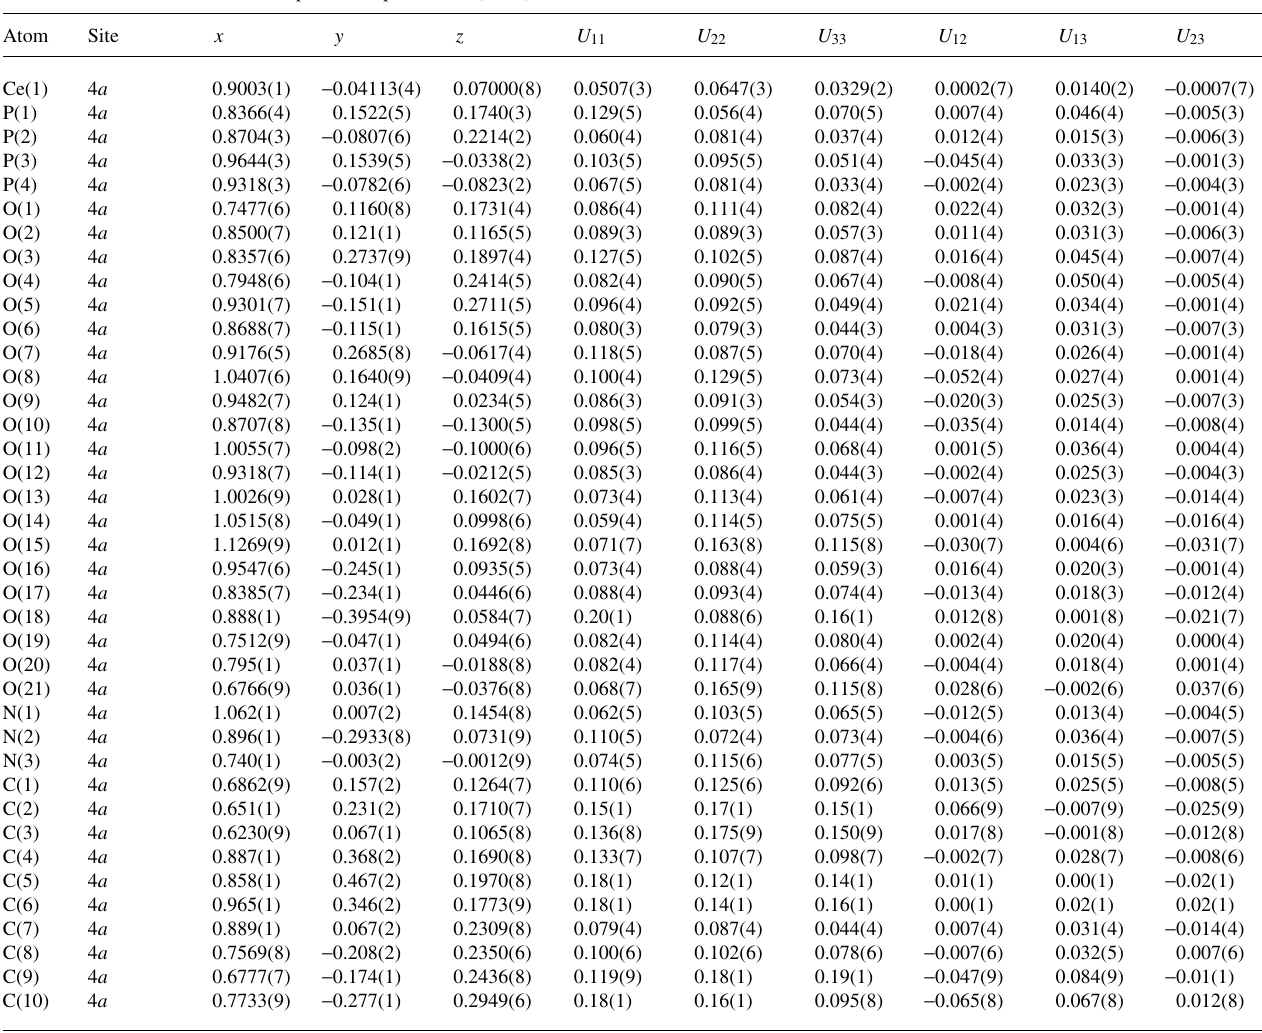
Table 3. Atomic coordinates and displacement parameters (in Å 2 )